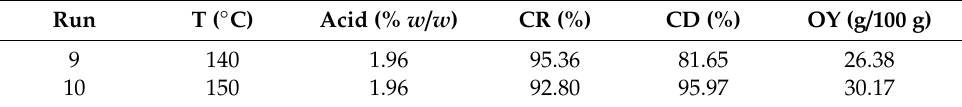
Table 4. Additional runs performed to test the OY